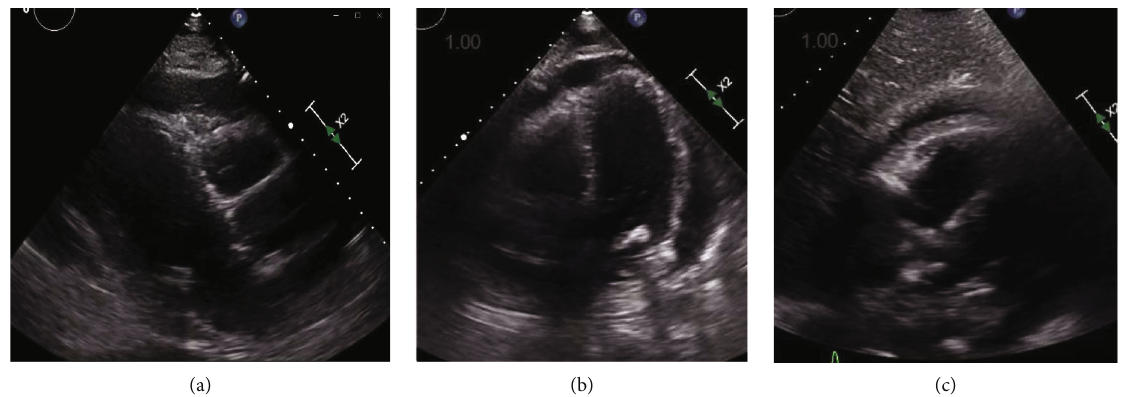
Figure 3: Parasternal long (a), apical 4-chamber view (b), and subxiphoid view (c) via echocardiography of expanding pericardial e ff usion on hospital day 7. No right atrial or right ventricular collapse or respiration variation in mitral or tricuspid in fl ow was seen. The inferior vena cava (IVC) was enlarged without collapse.